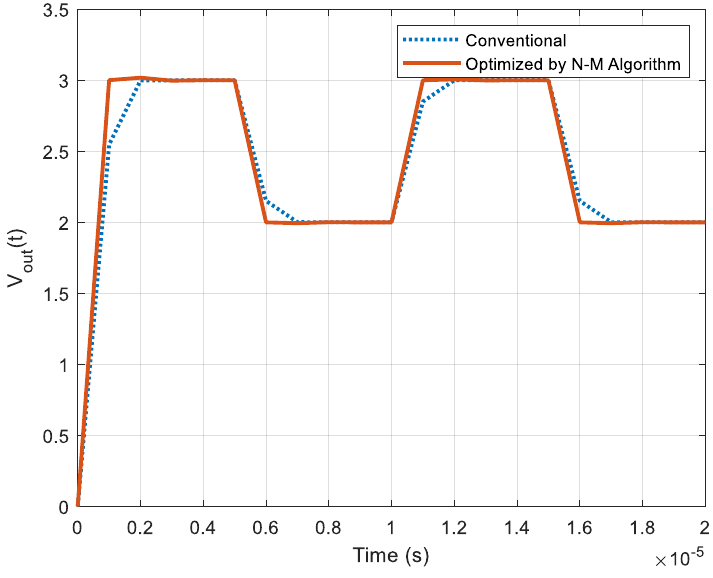
Figure 9. Set-point tracking performance offered by digital compensators.